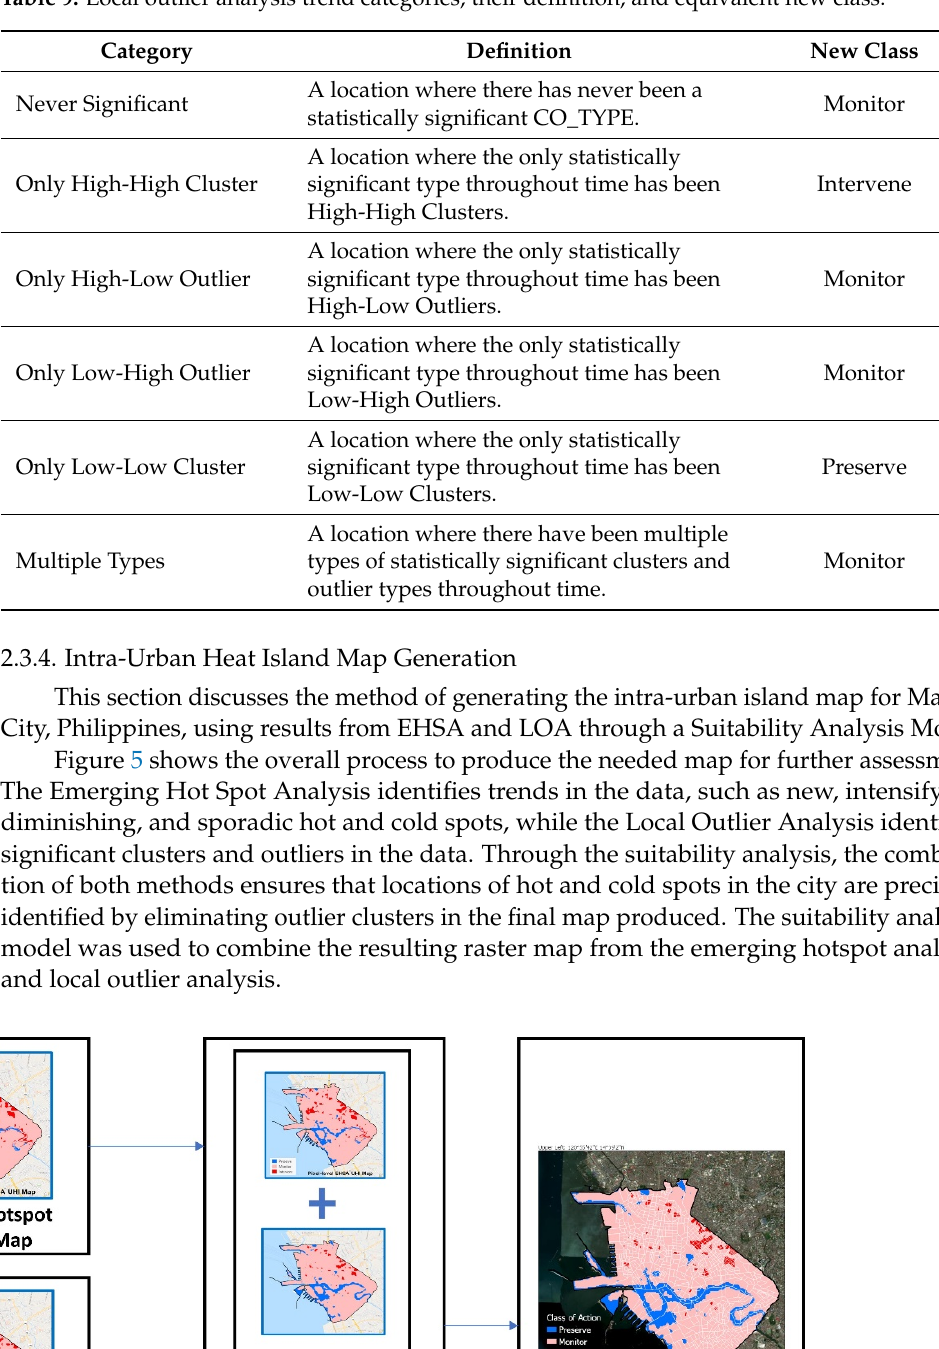
Table 9. Local outlier analysis trend categories, their definition, and equivalent new class.